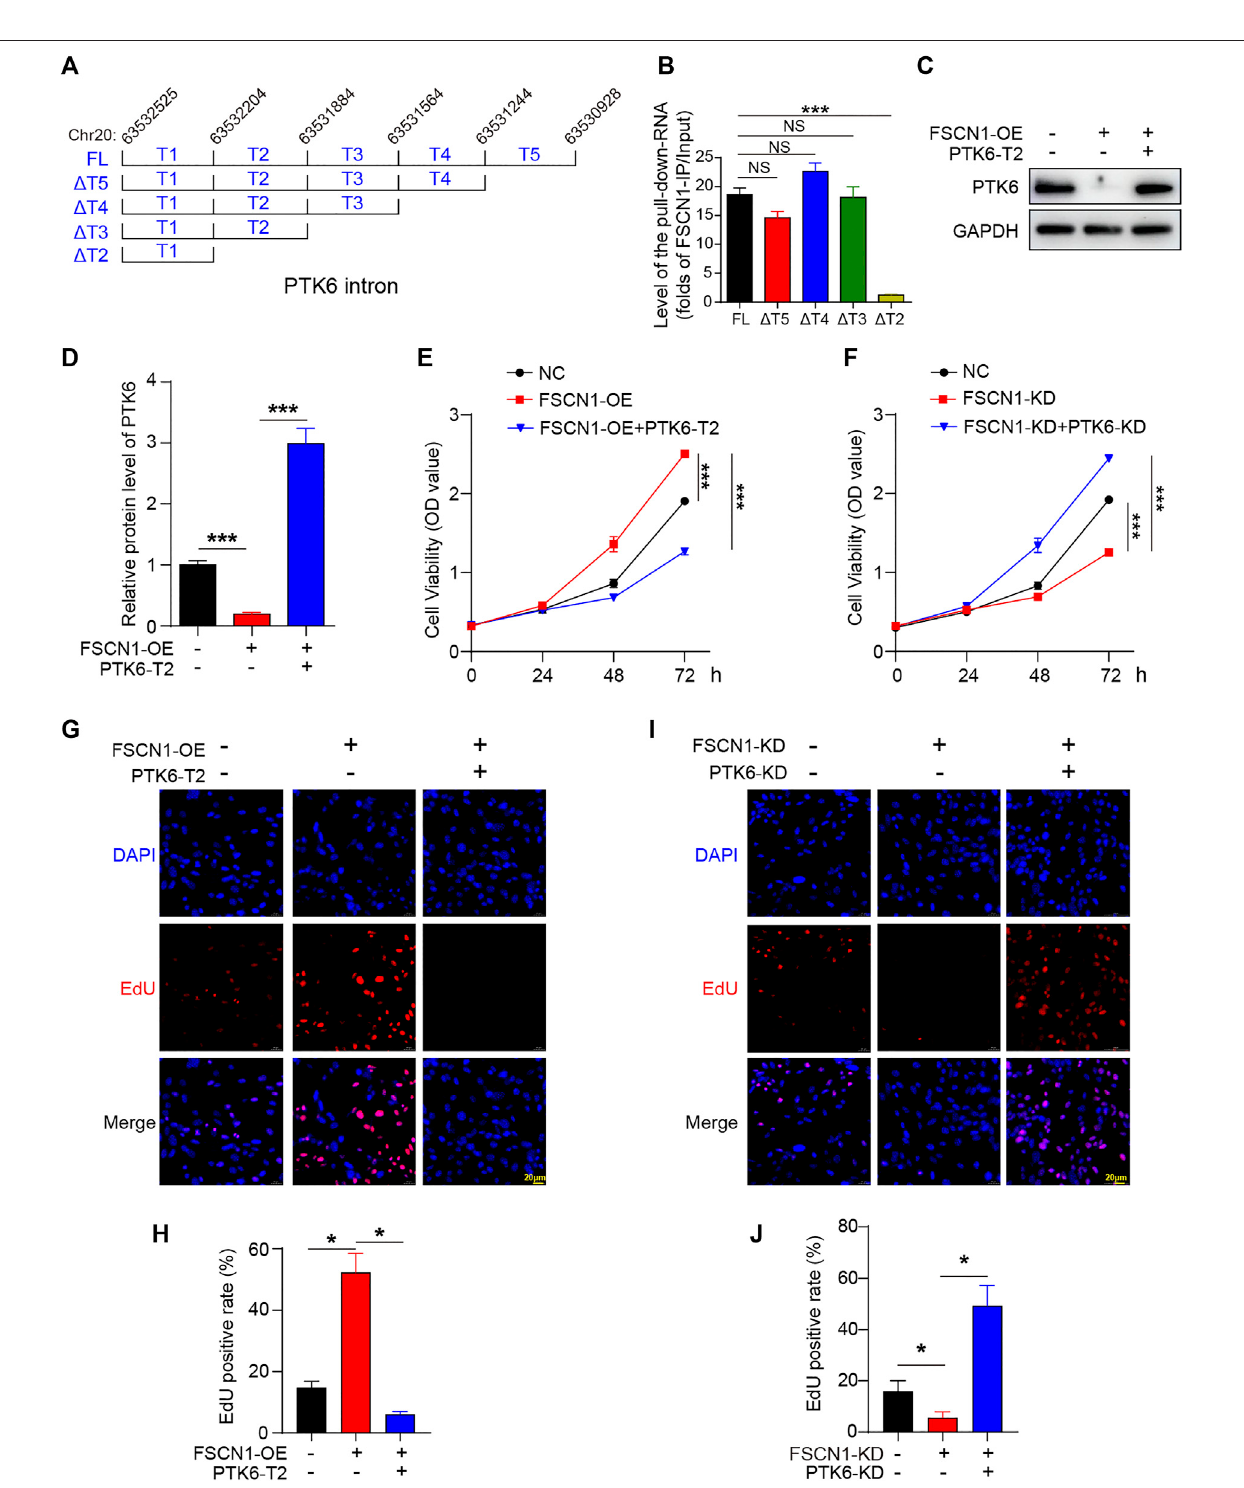
FIGURE 3 | The binding region of the pre-mRNA of PTK6 with FSCN1 is PTK-T2 (A) Schematic diagram of the full length and truncated mutant of PTK6 intron located in chromosome 20. (B) Plasmids expressing PTK6-FL and fi ve truncated mutants ( Δ T5, Δ T4, Δ T3 and Δ T2) were transfected into ECA-109 for 48 h. RIP was performedusingtheFSCN1antibody.Thepull-downRNAlevelwasdetected. n =3pergroup,*** p < 0.001. (C) CulturedECA-109cellswereinfectedwithNC,FSCN1- OE,andFSCN1-OE+PTK6-T2asindicated. Theprotein levelofPTK6wasdetected bywesternblotting (D) StatisticalanalysisofC. n =3per group,*** p < 0.001. (E) CCK-8 assay was performed in cultured ECA-109 cells infected with NC, FSCN1-OE, and FSCN1-OE + PTK6-T2 as indicated. n = 3 per group, *** p < 0.001. (F) CCK-8assay was performed in cultured ECA-109 cells infected with NC,FSCN1-KD, and FSCN1-KD +PTK6-KDas indicated. n = 3per group, *** p < 0.001. (G) ECA- 109cellsexpressing NC,FSCN1-OE, andFSCN1-OE +PTK6-T2asindicatedwerestainedbyEdU. (H) StatisticalanalysisofG. n =3per group,* p < 0.05. (I) ECA-109 cells expressing NC, FSCN1-KD, and FSCN1-KD + PTK6-KD as indicated were stained by EdU. (J) Statistical analysis of I. n = 3 per group, * p < 0.05. Frontiers in Pharmacology |